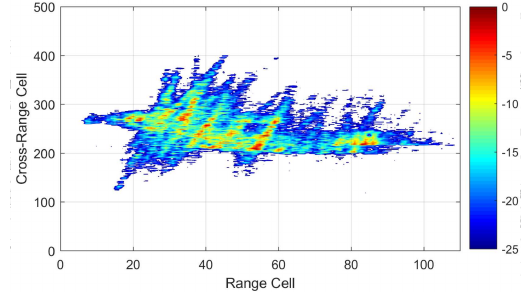
Figure 8. A moving ship image via spaceborne